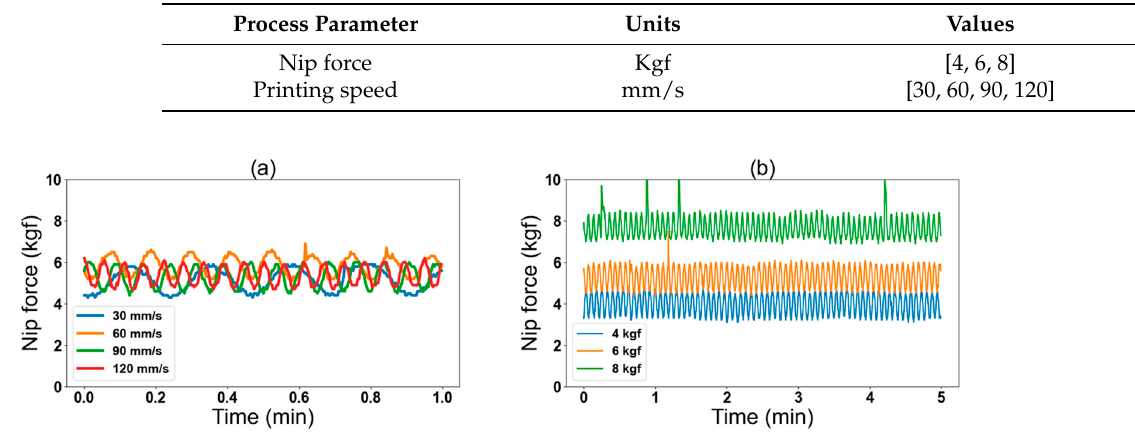
Figure 7. ( a ) NIP2_M data at varying printing speed and ( b ) NIP2_M data at different nip forces.